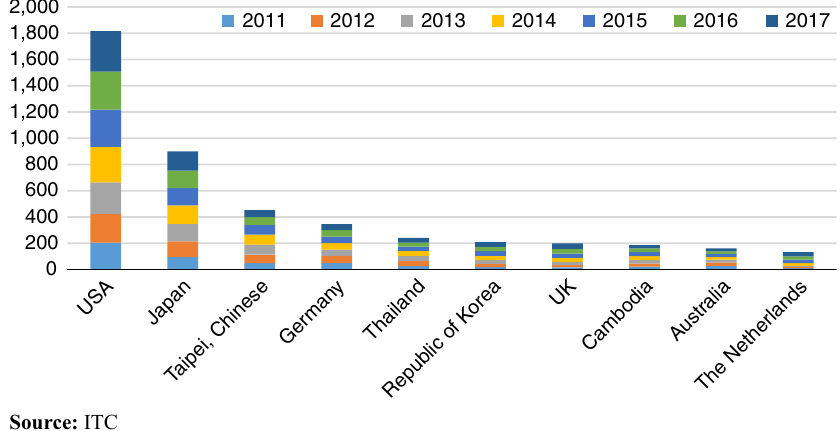
Figure 2. Top 10 largest import markets of Vietnamese